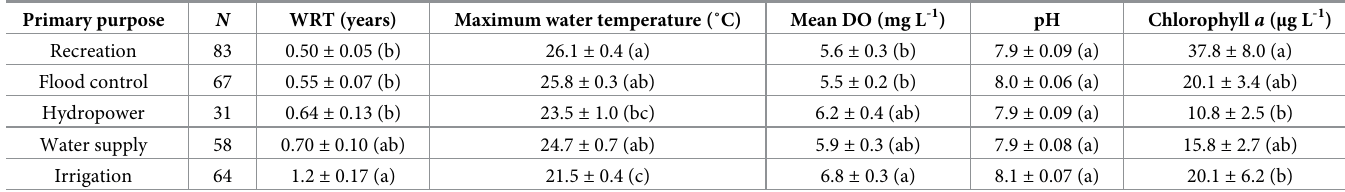
Letters denote statistical differences across different reservoir purposes based on one-way ANOVA with post-hoc Tukey pairwise comparisons. N refers to the sample size of each reservoir